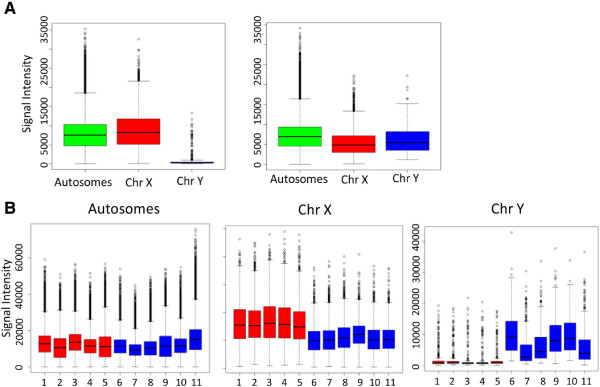
Changes in Infinium probe intensities between sex chromosomes. (A) Box plots of Infinium total signal intensities for autosomes and sex chromosomes for male and female patients (autosome (green) and sex chromosomes (chromosome X (red), chromosome Y (blue)). (B) Box plots of Infinium intensities for autosomes and sex chromosomes for 11 chondrosarcoma samples (females, red; males, blue).